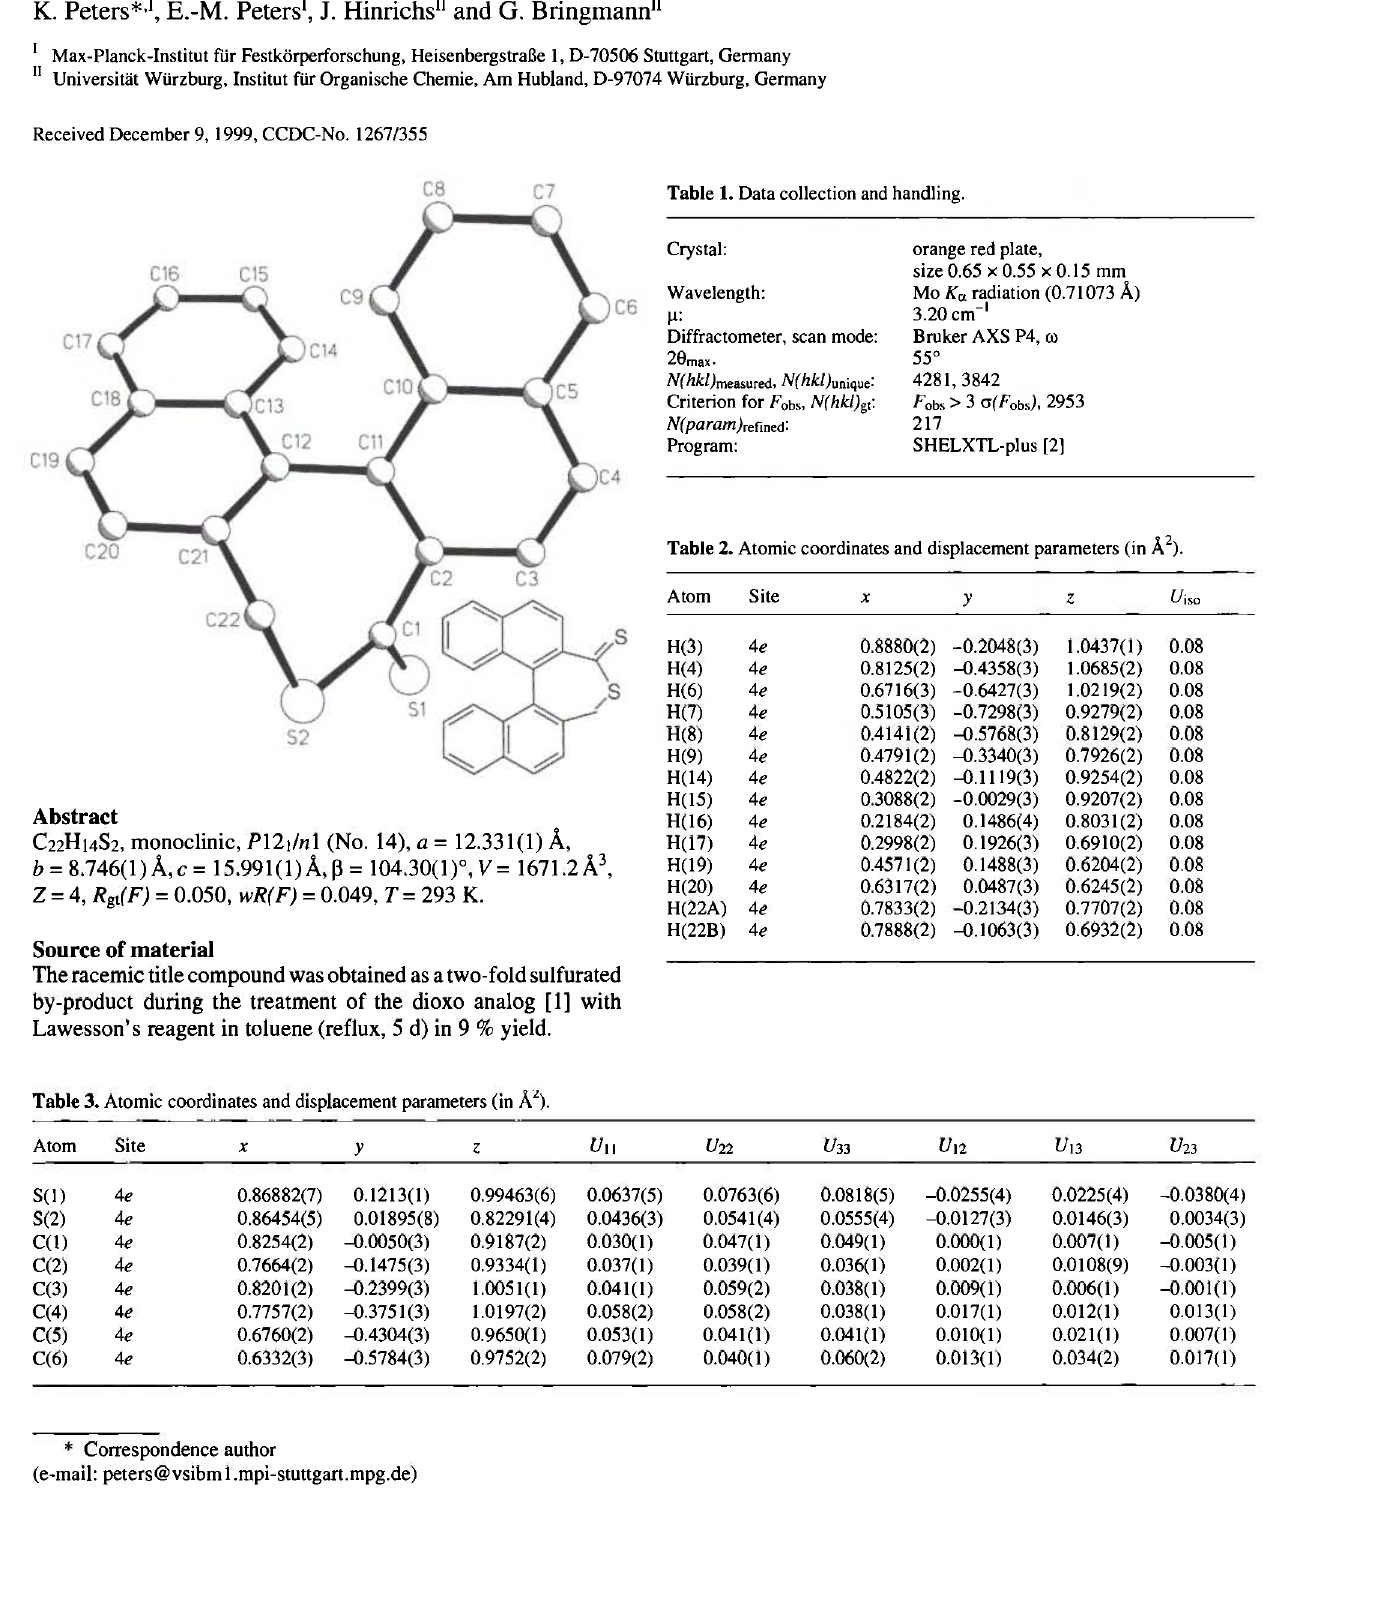
Table 1. Data collection and handling.